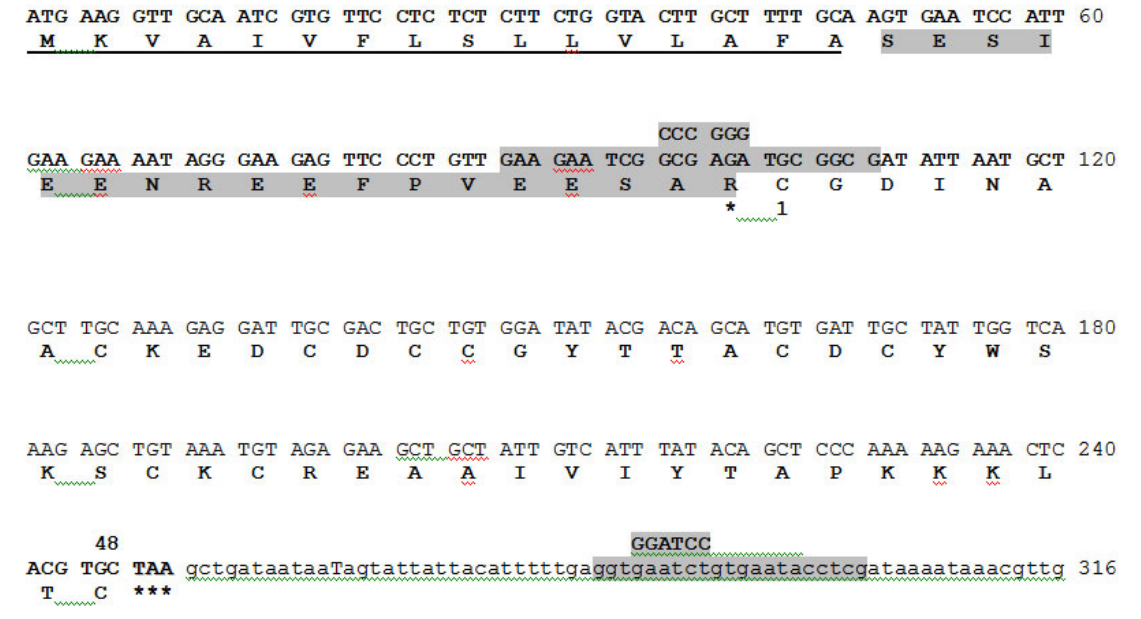
Figure 1. Partial sequence and deduced precursor polypeptide of the TX4(6-1) cDNA clone. The signal peptide with sixteen amino acid residues responsible for targeting the propolypeptide to endoplasmic reticulum is underlined and the shaded sequence corresponds to amino acid residues removed by proteases in the lumen of the venom glands (35). The first and the last amino acid residue in the native active TX4(6-1) peptide are indicated by numbers 1 and 48, respectively. The position of a glycine residue introduced in the active peptide sequence after cloning in pMAL-2 (*) and stop codon (***) are indicated. Shadowed regions in DNA indicate the position and sequence of synthetic primers used for amplification by PCR. Mutations creating recognition sites for Sma I (CCCGGG) and Bam H I (GGATCC) restriction enzymes are shown above the original cDNA